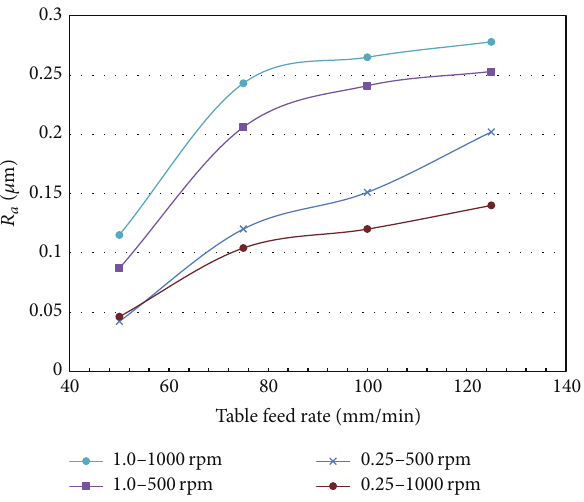
Figure 4: Effect of table feed rate on 𝑅 𝑎 for two values of depth of cut, of 1.0 and 0.25 mm, for two rotational spindle speeds of 500 and 1000